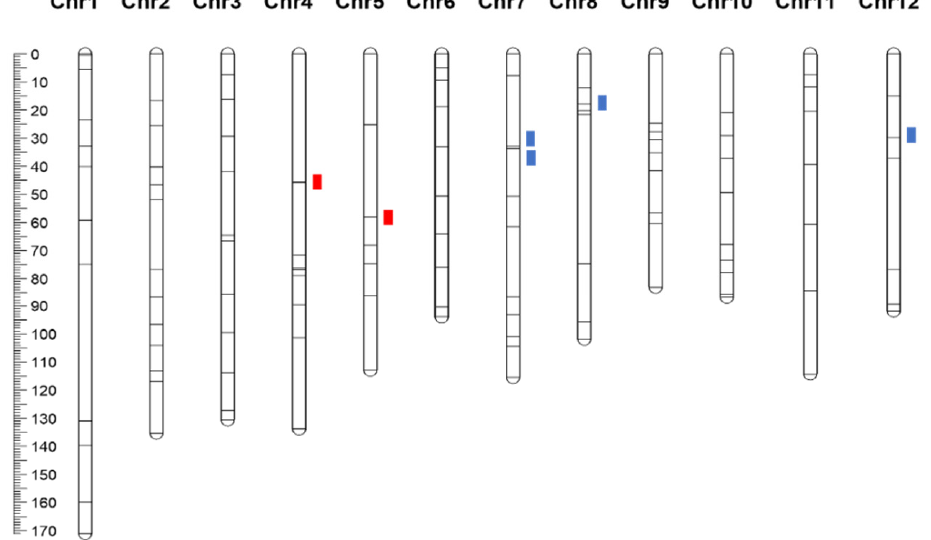
Figure 2. Genetic positions of detected QTLs for tiller number in CSSLs in Fuyang and Lingshui. The blue boxes indicate the detected QTLs in Fuyang, and the red ones show the QTLs detected in Lingshui. The scale on the left indicates map distance in centimorgans (cM). QTL, quantitative trait loci; CSSLs, chromosome segment substitution lines.